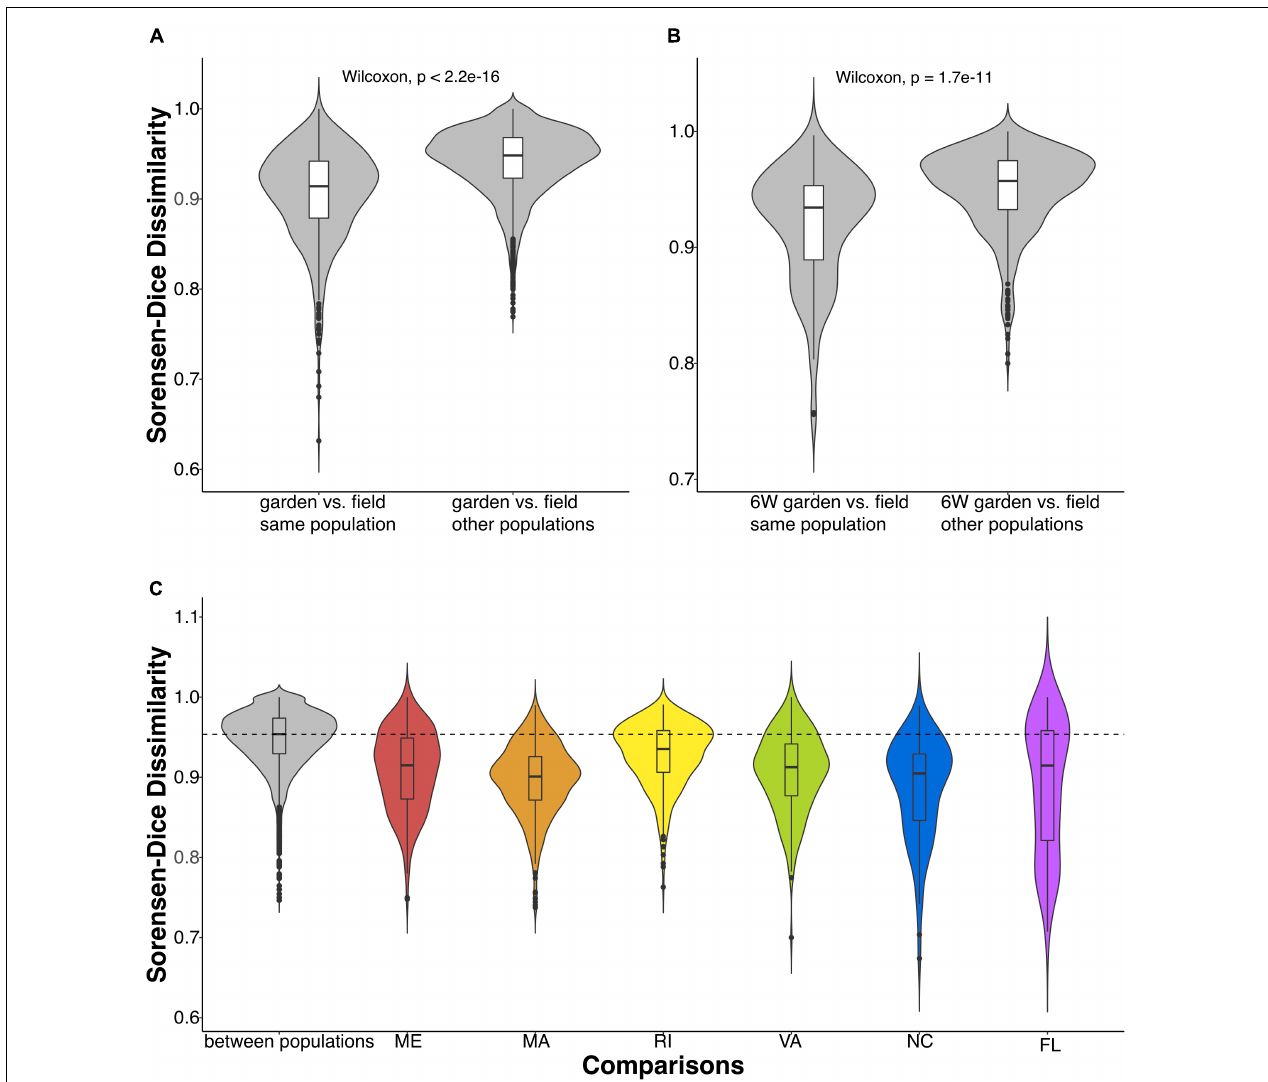
FIGURE 2 | Violin plots comparing Sorensen-Dice dissimilarities of gill-associated microbial communities between and within oyster populations. (A) Comparisons of common garden vs. field oysters within and between populations (Wilcoxon, p < 2.2e-16). (B) Comparisons of oysters at the last time point (in the common garden for 6 weeks) and oysters collected in the field between and within populations (Wilcoxon, p < 1.7e-11). (C) Common garden samples compared between populations (in gray) and within each population. The dashed line indicates the mean of the between-population Sorensen-Dice